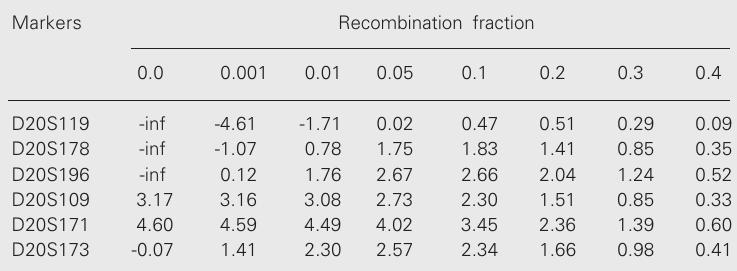
Table 1. Results of two-point linkage analysis between SMAN1 locus and 20q13.2- 13.3 markers.